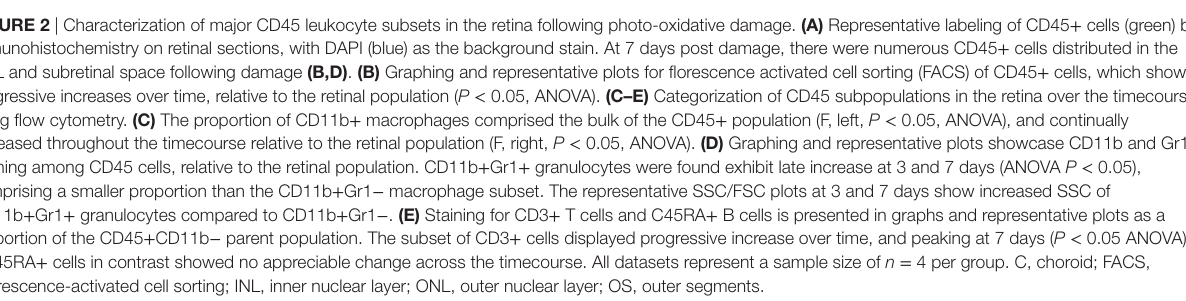
FigUre 2 | Characterization of major CD45 leukocyte subsets in the retina following photo-oxidative damage. (a) Representative labeling of CD45 + cells (green) by immunohistochemistry on retinal sections, with DAPI (blue) as the background stain. At 7 days post damage, there were numerous CD45 + cells distributed in the ONL and subretinal space following damage (B,D) . (B) Graphing and representative plots for florescence activated cell sorting (FACS) of CD45 + cells, which show progressive increases over time, relative to the retinal population ( P < 0.05, ANOVA). (c–e) Categorization of CD45 subpopulations in the retina over the timecourse, using flow cytometry. (c) The proportion of CD11b + macrophages comprised the bulk of the CD45 + population (F, left, P < 0.05, ANOVA), and continually increased throughout the timecourse relative to the retinal population (F, right, P < 0.05, ANOVA). (D) Graphing and representative plots showcase CD11b and Gr1 staining among CD45 cells, relative to the retinal population. CD11b + Gr1 + granulocytes were found exhibit late increase at 3 and 7 days (ANOVA P < 0.05), comprising a smaller proportion than the CD11b + Gr1 − macrophage subset. The representative SSC/FSC plots at 3 and 7 days show increased SSC